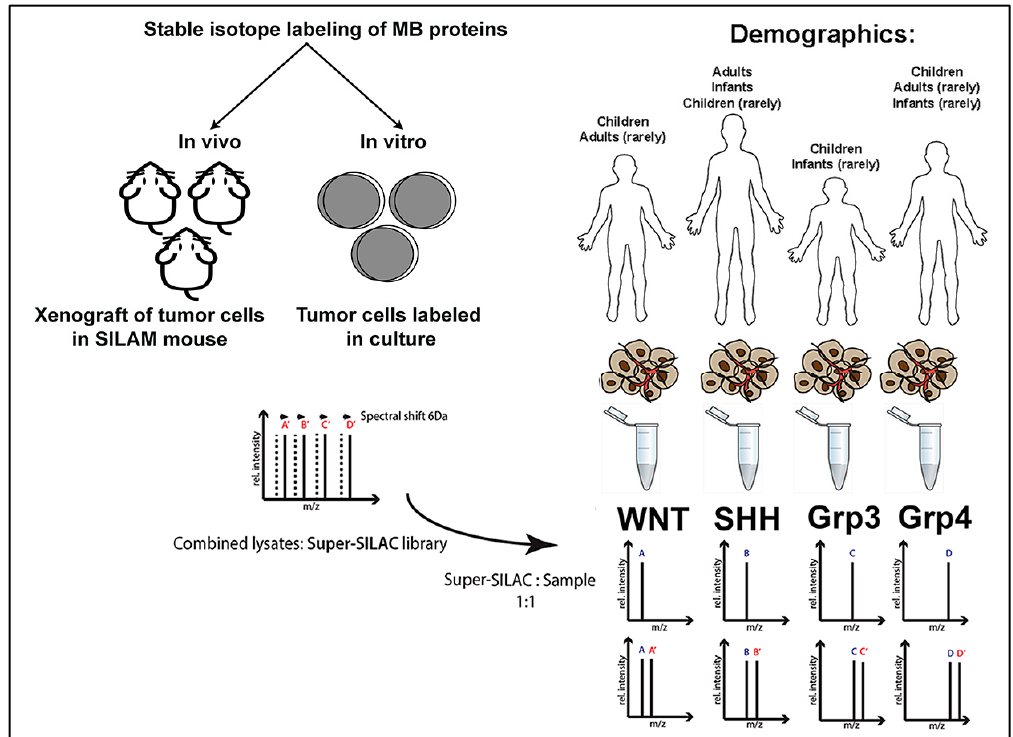
Figure 2. Schematic presentation of super-SILAC (stable isotopic labeling by amino acids in cell culture) methodology. All proteins within different medulloblastoma primary/cell lines are isotopically labeled, in vivo (using stable isotope labeling of amino acids in mammals: SILAM) or in vitro, through incorporation of 13 C 6 -Arg (MB—medulloblastoma). This causes a known shift of 6 Da in the mass spectrometry spectra. The combined lysates of the isotopically labeled cultures are mixed (1:1 ratio) with tumor lysates from different medulloblastoma tumor/cell samples resulting in two spectra profiles per protein (separated by 6 Da). The protein of interest can now be quantified in the sample as a ratio of the isotopically labeled protein in the same sample.